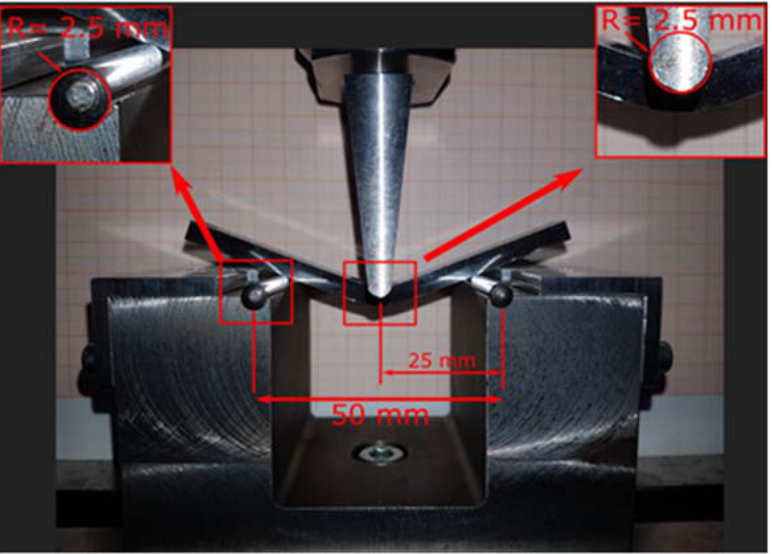
Figure 5. Relevant dimensions of the bending device.